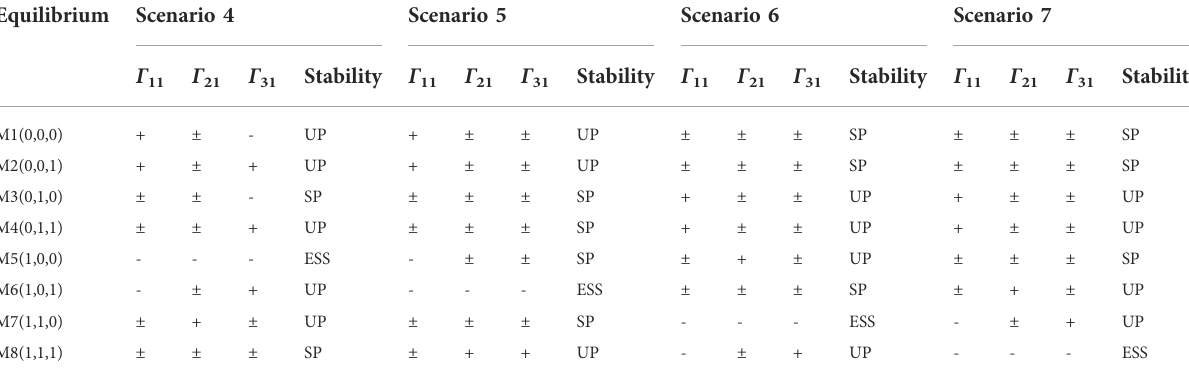
TABLE 5 Stability analysis of equilibrium points for Scenarios 4 – 7